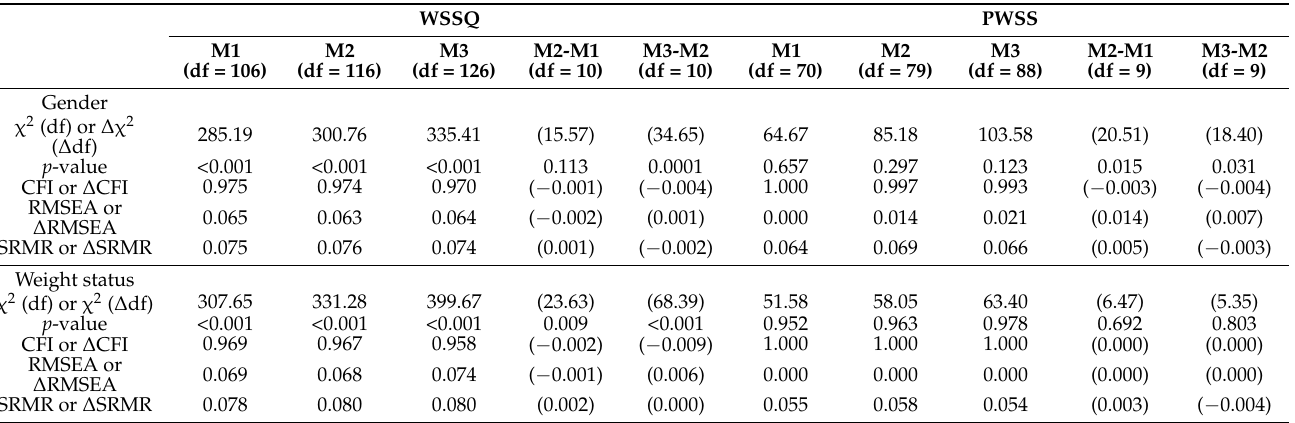
WSSQ: Weight Self-Stigma Questionnaire; PWSS: Perceived Weight Stigmatization Scale; CFI: Comparative fit index; RMSEA: Root mean square error of approximation; SRMR: Standardized root mean square residual; M1: Configural model; M2: Model with factor loadings constrained equal across groups; M3: Model with both factor loadings and item intercepts constrained to be equal across groups. For the PWSS (Table 3), the factor-loading constrained models showed significant χ 2 difference from the configural models across the gender group ( ∆ χ 2 = 20.51 ( p = 0.015)) and nonsignificant χ 2 difference from the configural models across the weight status group ( ∆ χ 2 = 6.47 ( p = 0.692)). The factor-loading constrained models and items-intercept constrained models showed significant χ 2 difference from the configural models across the gender group ( ∆ χ 2 = 18.40 ( p = 0.031) and nonsignificant χ 2 difference from the configural models across weight status group ( ∆ χ 2 = 5.35 ( p = 0.803)). However, all values of ∆ CFI, ∆ RMSEA, and ∆